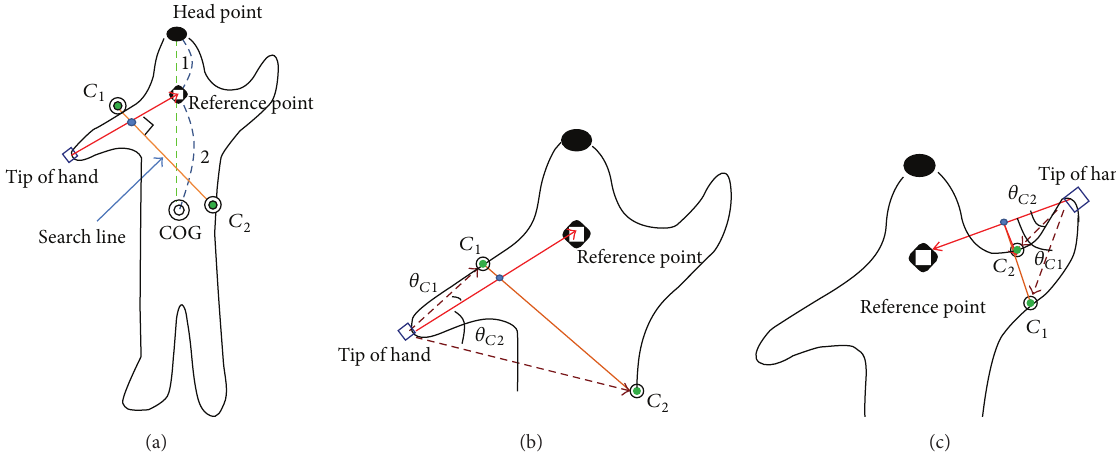
Figure 6: (a) Locations of the two elbow candidates on the contour. (b) and (c) The candidate points 𝐶 1 and 𝐶 2 and the included angles 𝜃 𝐶 and 𝜃 𝐶 for locating the elbows in the hands. 2